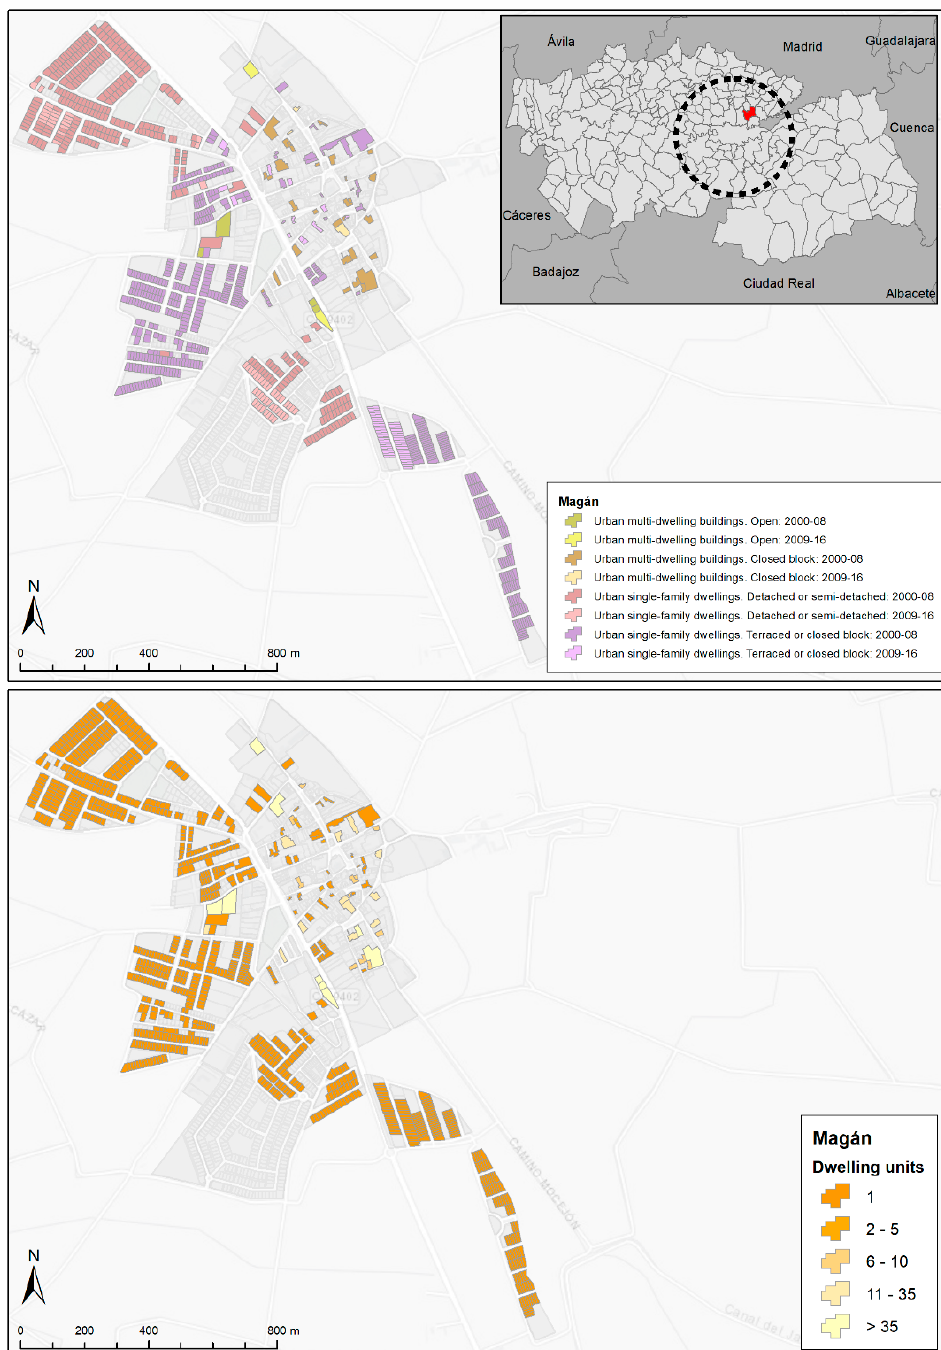
Figure 9. Number of dwellings and construction types (Magán). Own elaboration.